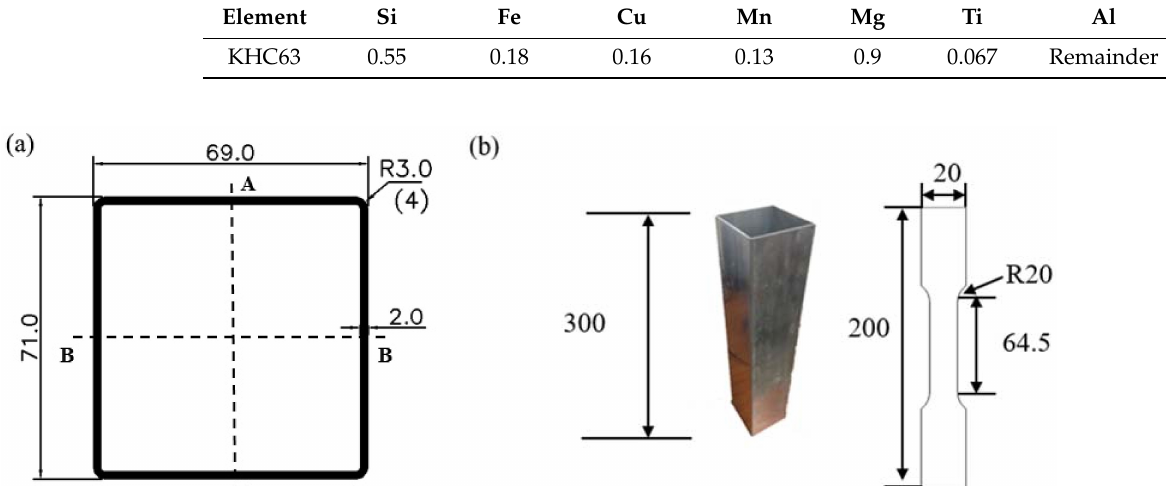
Figure 1. ( a ) Profile cross-section geometry diagram of the extrusions and ( b ) geometry of extruded workpiece and tensile specimens. All measures are in mm.